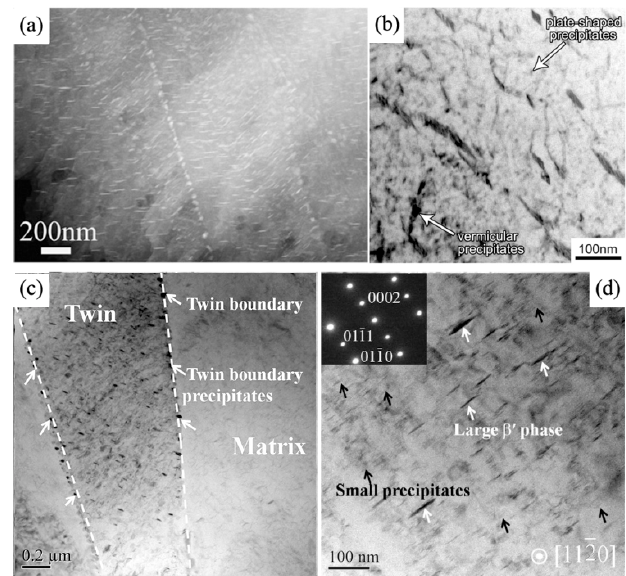
Figure 6. TEM micrographs of various samples ( a ) extruded Mg-4Sm alloy subjected 20% cold rolling and aging [37], ( b ) the Mg − 2.7Nd − 0.4Zn − 0.5Zr alloy with a pre-compressive strain of 8% and subsequently aged at 200 °C or 8 h [35], ( c , d ) are the twin boundary precipitates and matrix interior precipitates in the pre-deformed WE43 alloy, respectively [24].